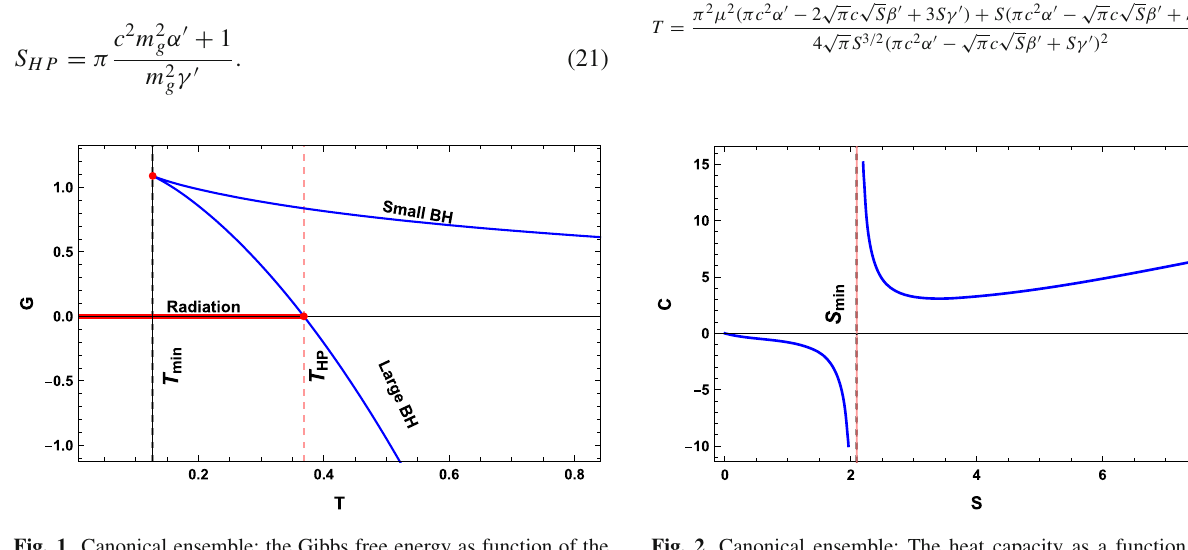
Fig. 2 Canonical ensemble: The heat capacity as a function of the entropy for the neutral BH, with m g = 1 , c = 1 , α = 1 and β =